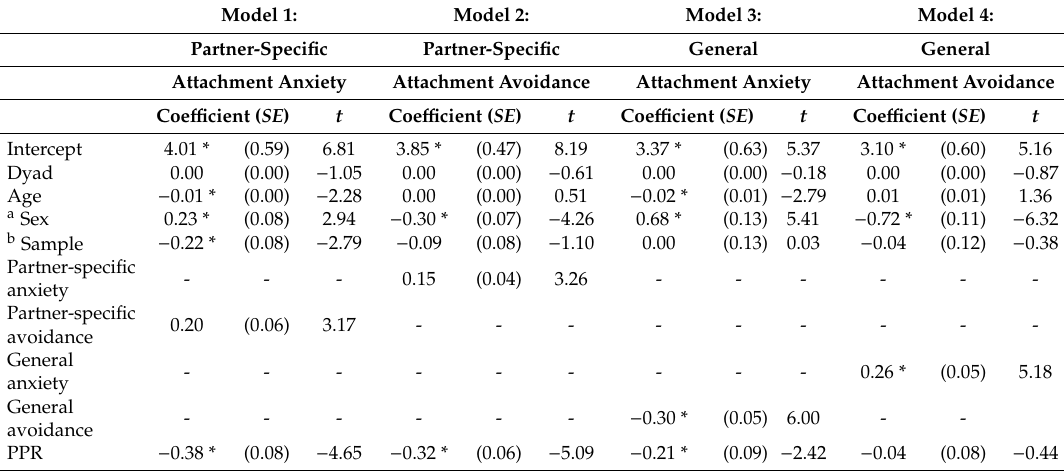
Table 2. Predicting partner-specific and general attachment anxiety and avoidance from perceived partner responsiveness. Model 1: Model 2: Model 3: Model 4: Partner-Specific Partner-Specific General